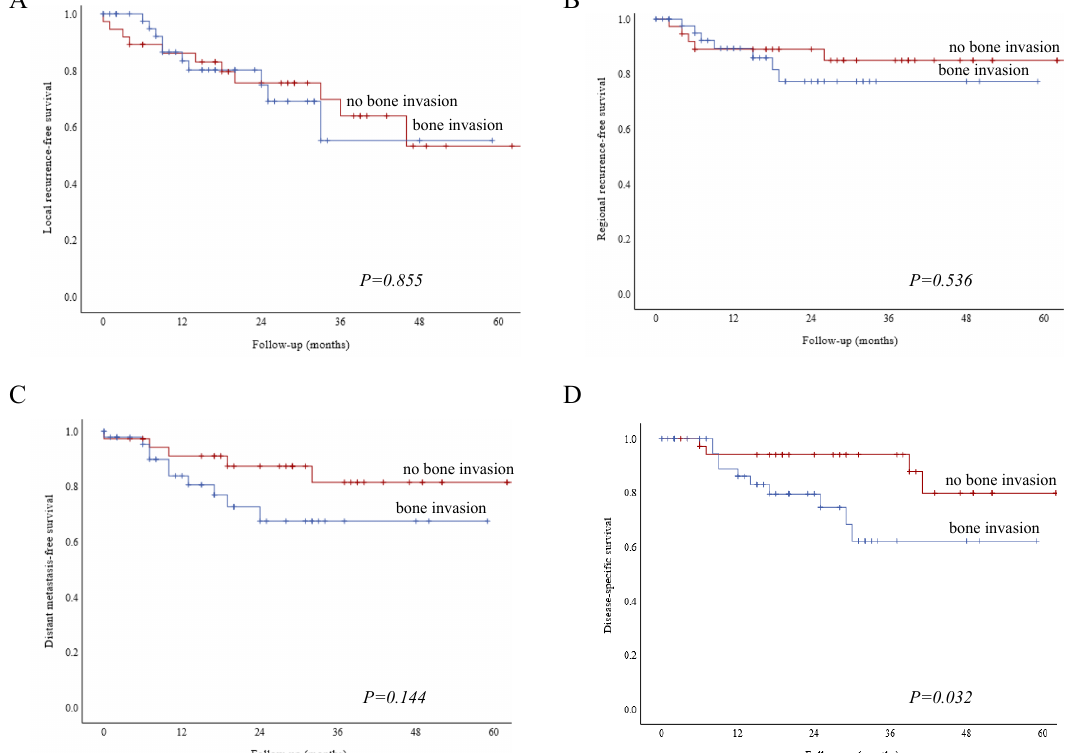
Figure 4. Kaplan–Meieranalysisshowingrelativesurvivalaccordingtoboneinvasion. Localrecurrence-free survival ( A , log-rank, p = 0.855), regional recurrence-free survival ( B , log-rank p = 0.536), and distant metastasis-free survival. ( C , log-rank, p = 0.144) were similar for both groups. Disease-specific survival was worse in patients with bone invasion ( D , log-rank, p =